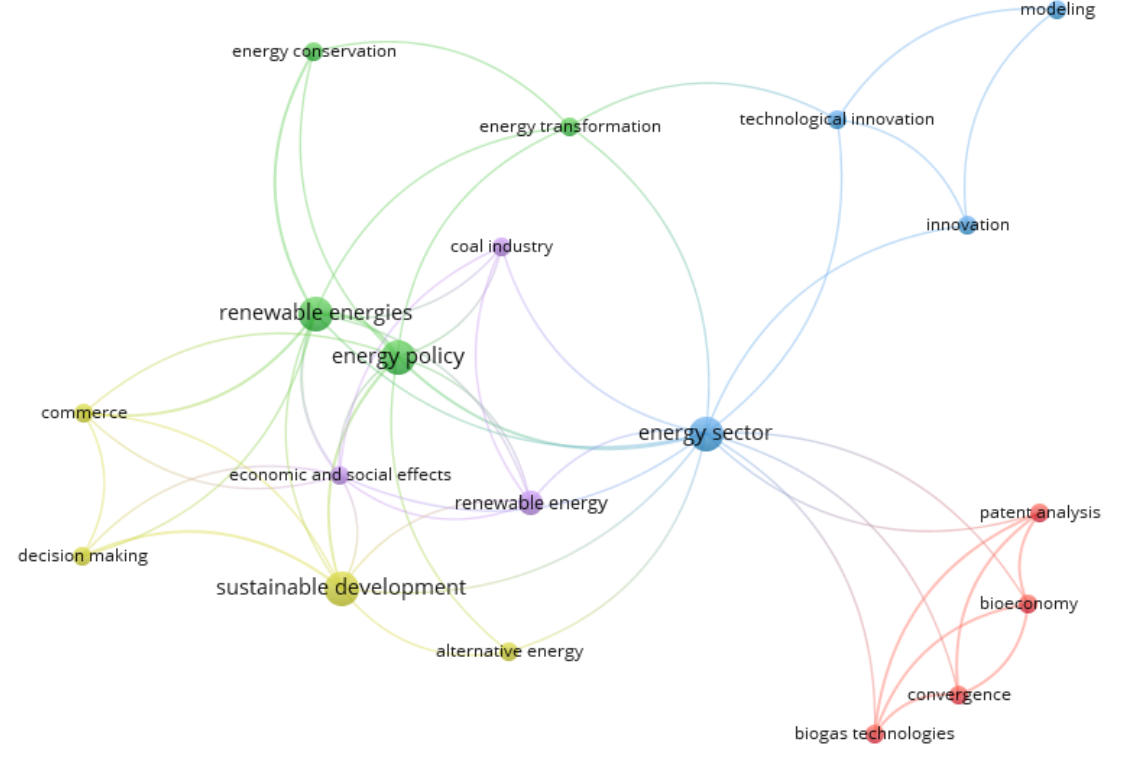
Figure 6. Bibliometric map of all keyword co-occurrence from Scopus based on Query 18’s results. Source: authors’ elaboration performed in VOSviewer (version 1.6.18).